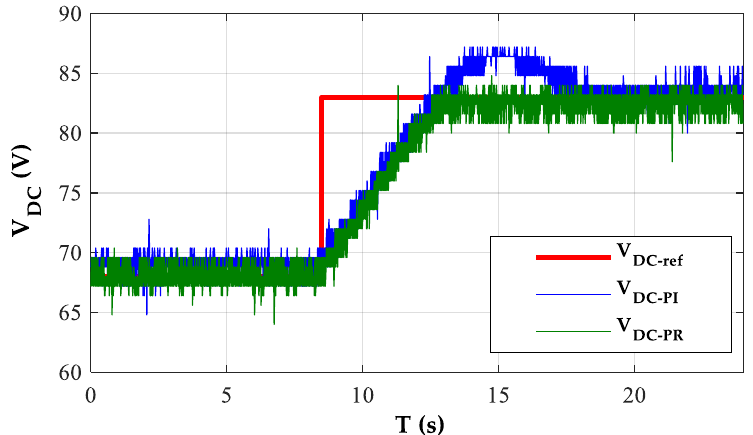
Figure 12. The experimental results of the voltage in the SRG power generation system under two controllers.